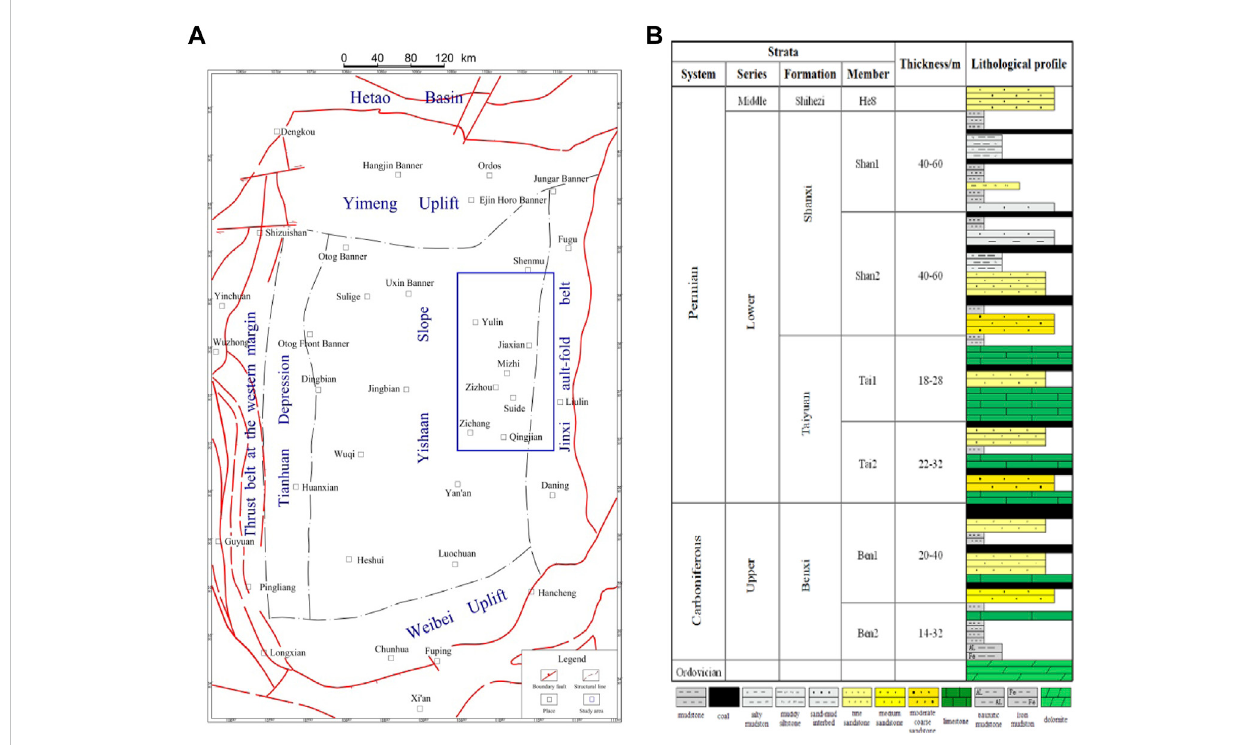
FIGURE 1 Tectonic unit division (A) and stratigraphic column (B) of the Carboniferous – Lower Permian in the Ordos Basin.